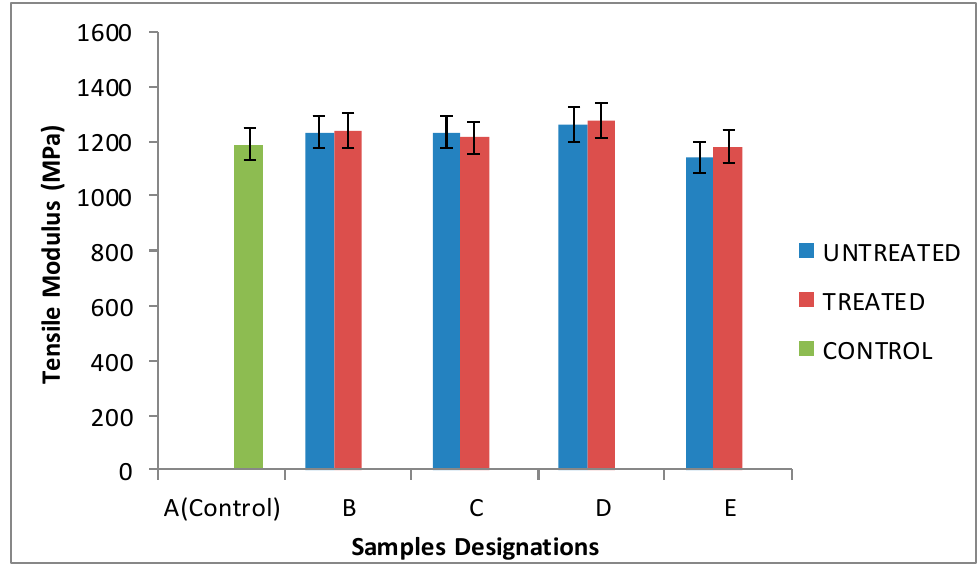
Figure 7. The tensile modulus of the control sample and the developed composites.